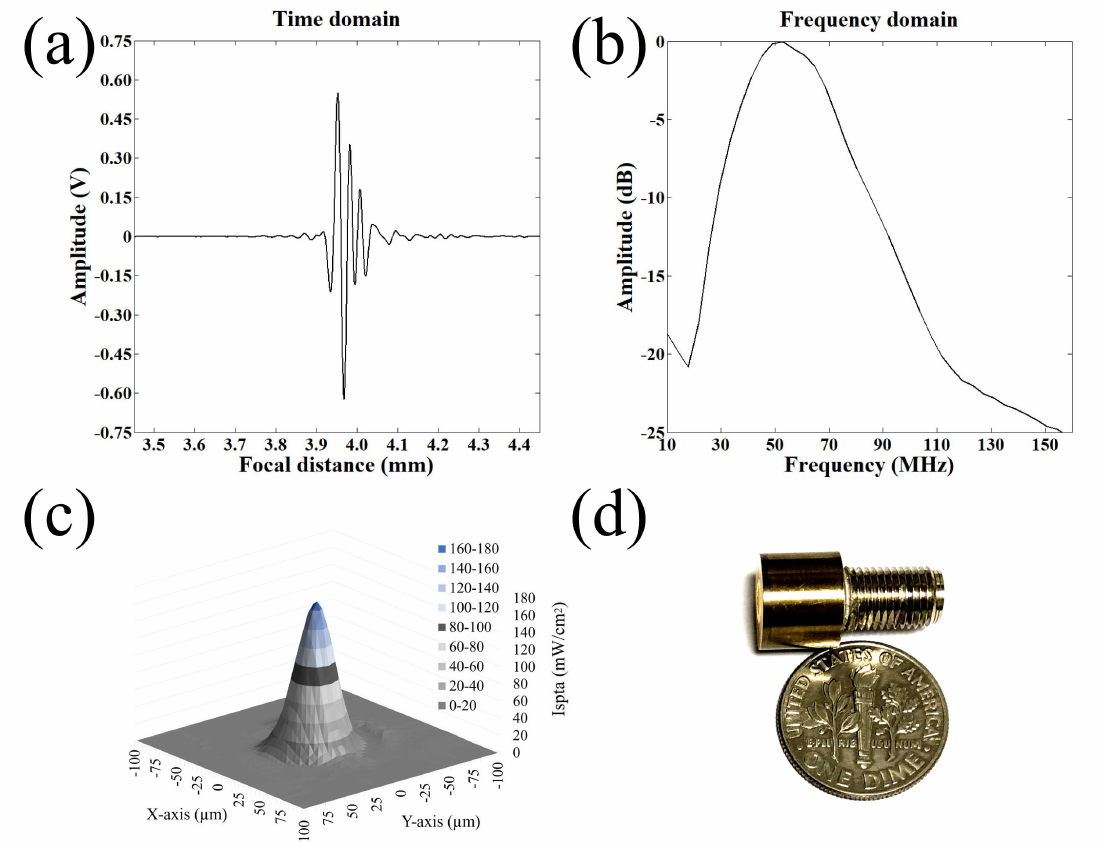
Figure 2. Fabrication of a highly focused 50 MHz transducer. ( a ) Receive-echo response. ( b ) Frequency spectrum. ( c ) 2D acoustic intensity field of spatial peak temporal average (ISPTA) was measured after a 50 MHz transducer was excited with the input parameters of V pp = 25 V, cycle numbers of 10, and pulse repetition frequency of 1 kHz. Acoustic pressure field of the ultrasonic transducers measured by a needle hydrophone. The − 3 dB lateral beam width was measured to be 32 µ m. ( d ) A photograph of the 50 MHz